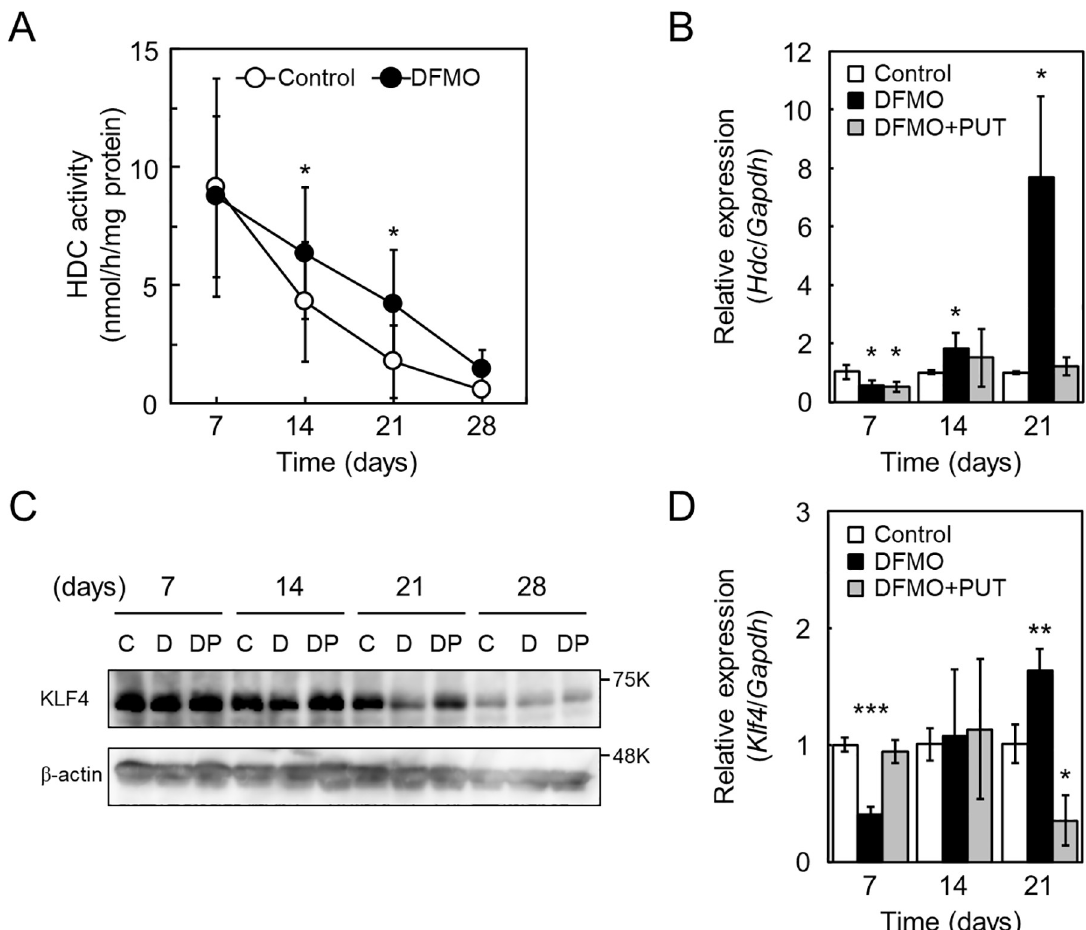
Fig 4. Hdc and Klf4 expression during BMMC differentiation in the absence or presence of DFMO. (A) During BMMC differentiation, cells on day 7, 14, 21, and 28 were collected and used to prepare cell lysates. HDC assays were performed after dialysis of the cell lysate. Mean ± s.d. is shown, n = 3 replicates. � p < 0.05 compared with control. (B) Total RNA extracted from cells on day 7, 14, and 21 was isolated and used for qRT-PCR. Relative expression of Hdc mRNA was normalized to Gapdh and control expression is shown as 1. Mean ± s.d. is shown, n = 3 replicates. � p < 0.05 compared with control. (C) During BMMC differentiation, cells on day 7, 14, 21, and 28 were collected and analyzed for KLF4 and β -actin by western blotting. Lanes (C, D, and DP) represent control, DFMO, and DFMO + PUT, respectively. (D) Total RNA from cells on day 7, 14, and 21 was isolated and used for qRT-PCR. Relative expression of Klf4 mRNA was normalized to Gapdh ; control expression is shown as 1. Mean ± s.d. is shown, n = 3 replicates. � p < 0.05, �� p < 0.01, and ��� p < 0.001, compared with